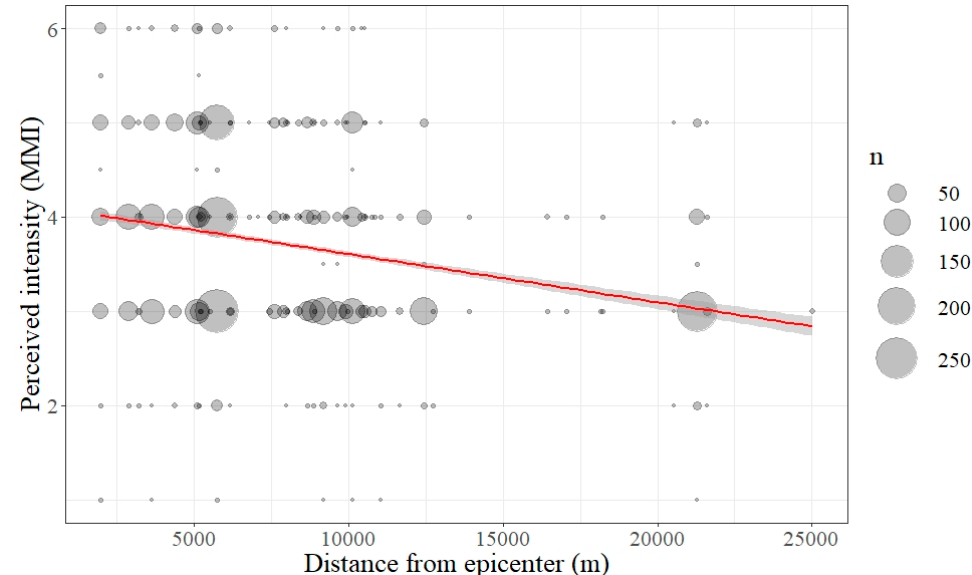
Figure 4. Level of Perceived Earthquake Intensity (Modified Mercalli Intensity (MMI)) and Distance from the Epicenter. The red line represents the smoothing trend line, and the gray belt around red line shows standard error. The perceived intensity decreases with distance from the epicenter.